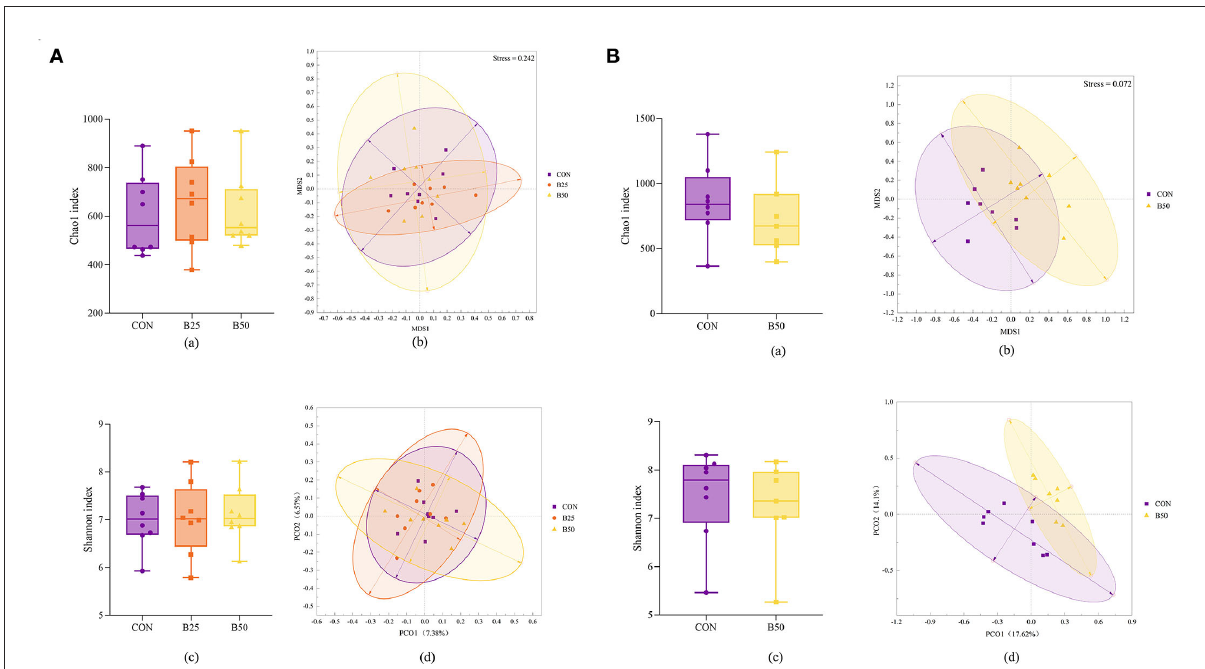
FIGURE4 α - and β -diversity of fecal and rumen fluid microflora affected by FPPR. (A) α - and β -diversity for fecal microflora: (a) Chao1 index; (b) non-metric multidimensional scaling (NMDS) plot; (c) Shannon index; (d) principal co-ordinates analysis (PCoA) plot; (B) α - and β -diversity for rumen fluid microflora: (a) Chao1 index; (b) NMDS plot; (c) Shannon index; (d) PCoA